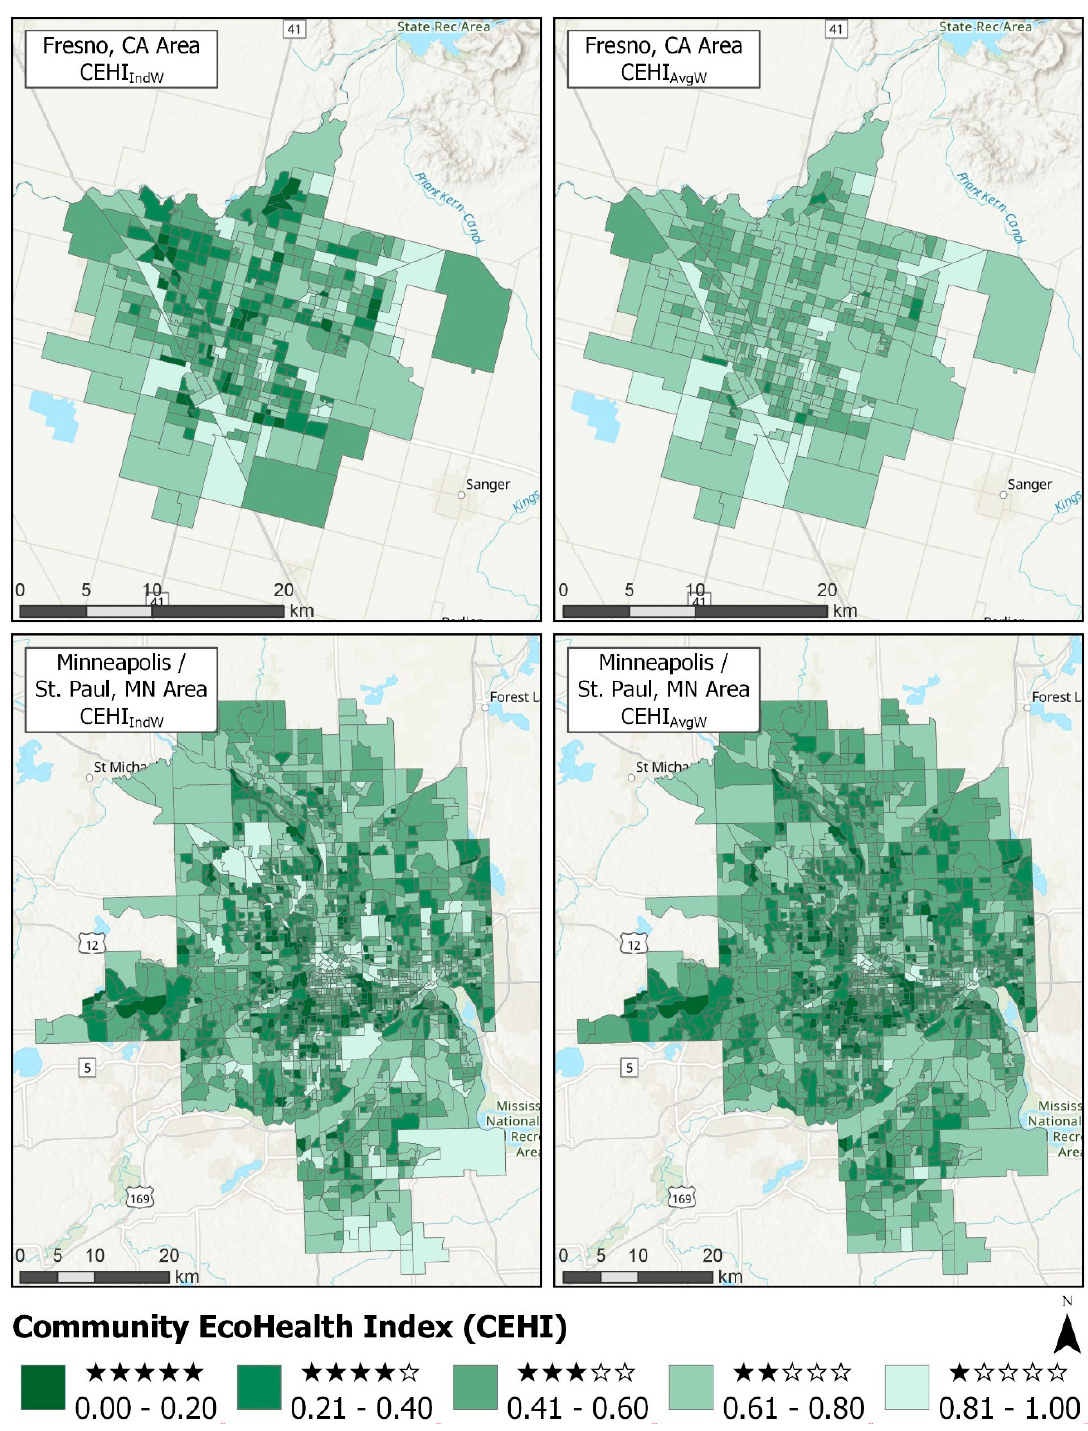
Figure 4. Maps of CEHI IndW and CEHI AvgW for Durham, NC area, Austin, TX area, Fresno, CA area, and Minneapolis/St. Paul, MN area. Across CBGs or neighborhoods, lower CEHI values correspond to more stars and darker green color.